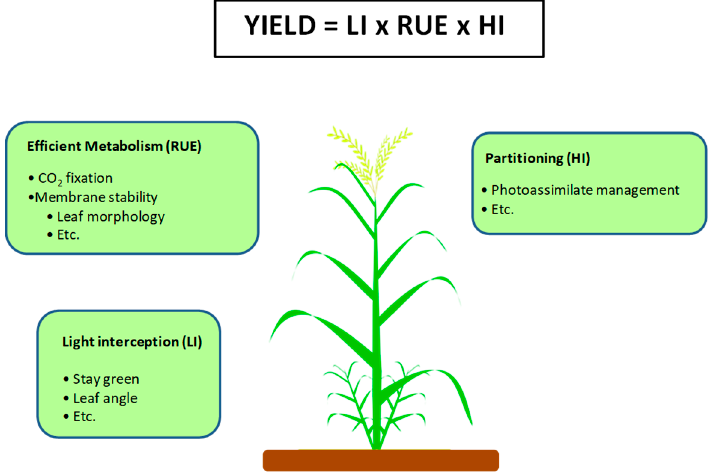
Figure 2. Photosynthesis as a strategy to improve crop yield. Grain yield improvement model developed by Passioura [120]. LI refers to light interception by the crop; RUE refers to radiation use efficiency, and HI refers to harvest index. Adapted from [147].